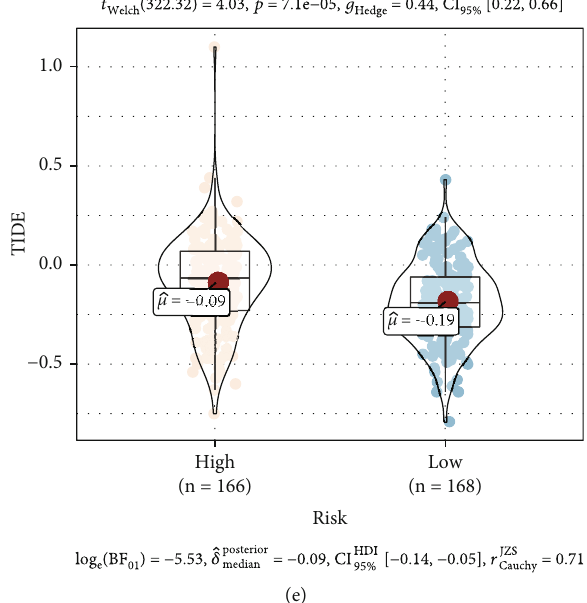
Figure 9: Prediction of immunotherapy responsiveness. (a) Relationships between the GIMiSig and immune checkpoint-related gene expression levels. Comparison of (b) microsatellite instability (MSI) score, (c) aneuploidy score, (d) tumor mutation burden (TMB), and (e) Tumor Immune Dysfunction and Exclusion (TIDE) score in the high- and low-risk groups. ∗ p < 0 : 05 , ∗∗ p < 0 : 01 , and ∗∗∗ p < 0 : 001